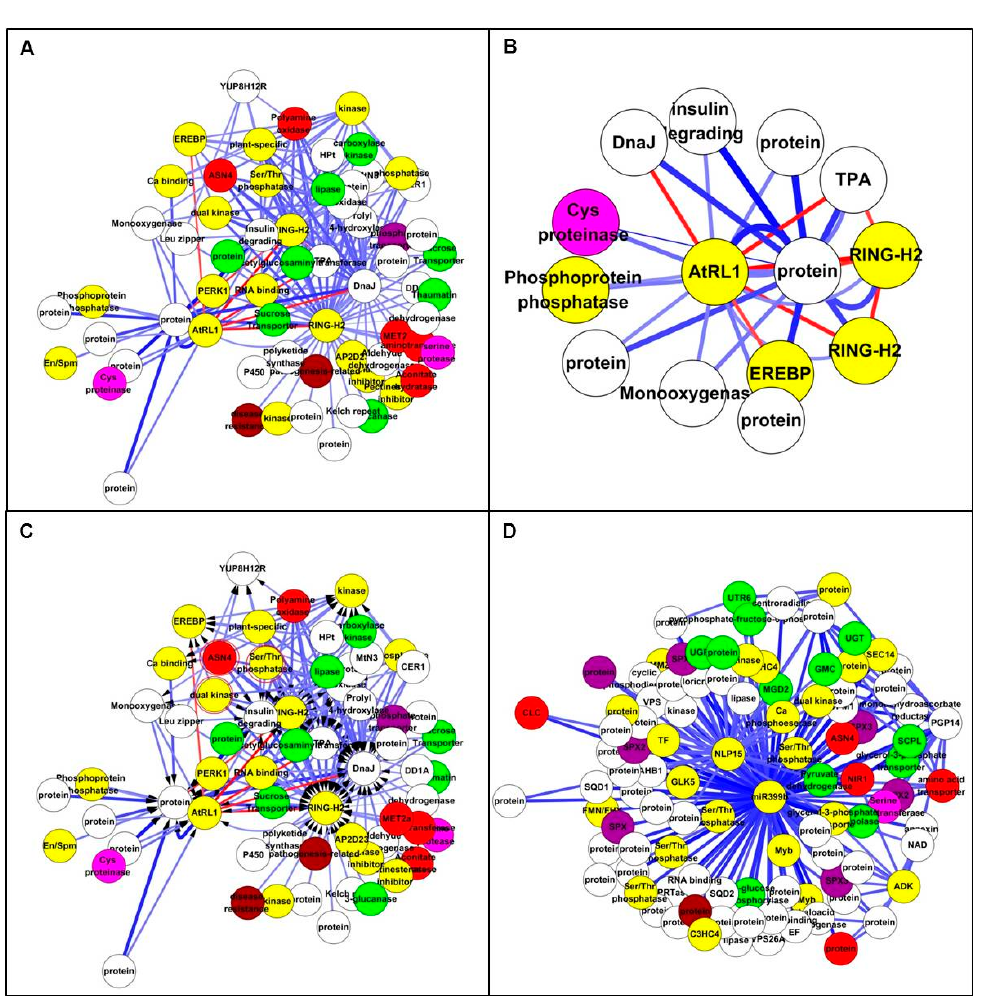
Figure 5. Top 200 interactions from all genes by ANN analysis. ( A ) All genes network with Top 200 interactions in Study 1. Nodes are coloured according to gene function: amino acid related in pink; carbon related in green; nitrogen related in red; phosphate related in purple; regulator and transcription factors (TFs) in yellow; stress related in brown; and others in white. ( B ) Extracted subnetwork in Study 1. AtRL1 interacted with other TFs such as RING-H2, EREBP and cysteine proteinase. ( C ) All genes network with Top 200 interactions. The nodes highlighted by red circle represent the three common genes: ZmASN4, dual specific kinase and Ser/Thr protein phosphatase. ( D ) Extracted sub-network with two central nodes: NLP15 and miR-399b. NLP15 and GLK5 were significantly down-regulated TFs under low N treatment.